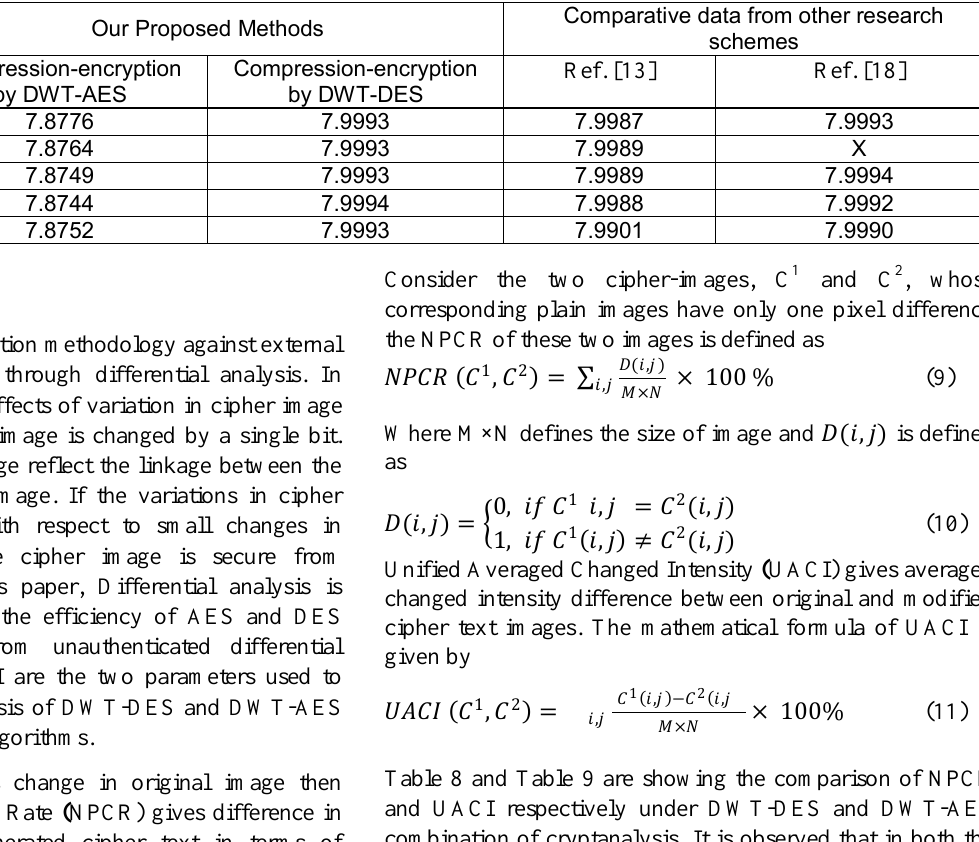
Table 7. Comparison of entropy analysis for different compression encryption techniques Our Proposed Methods Image